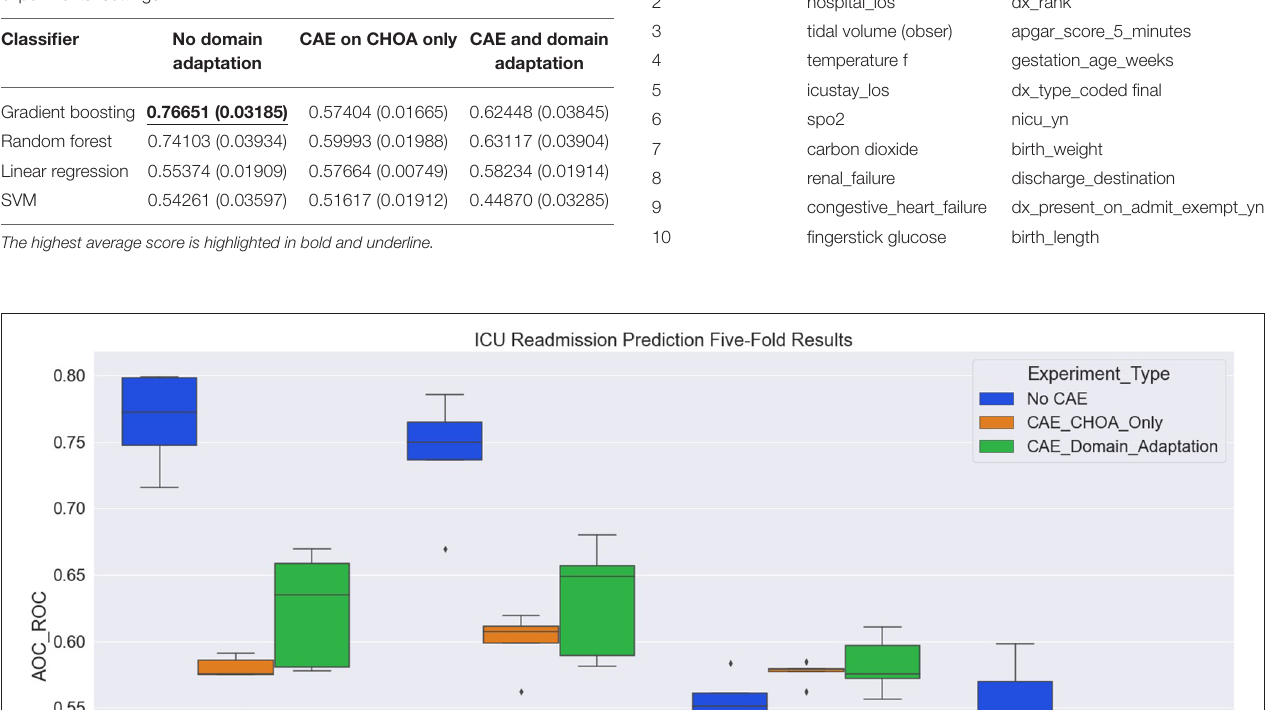
TABLE 6 | ICU readmission prediction results on Children’s Healthcare of Atlanta (CHOA) data (both temporal and non-temporal features) under three different experimental settings.